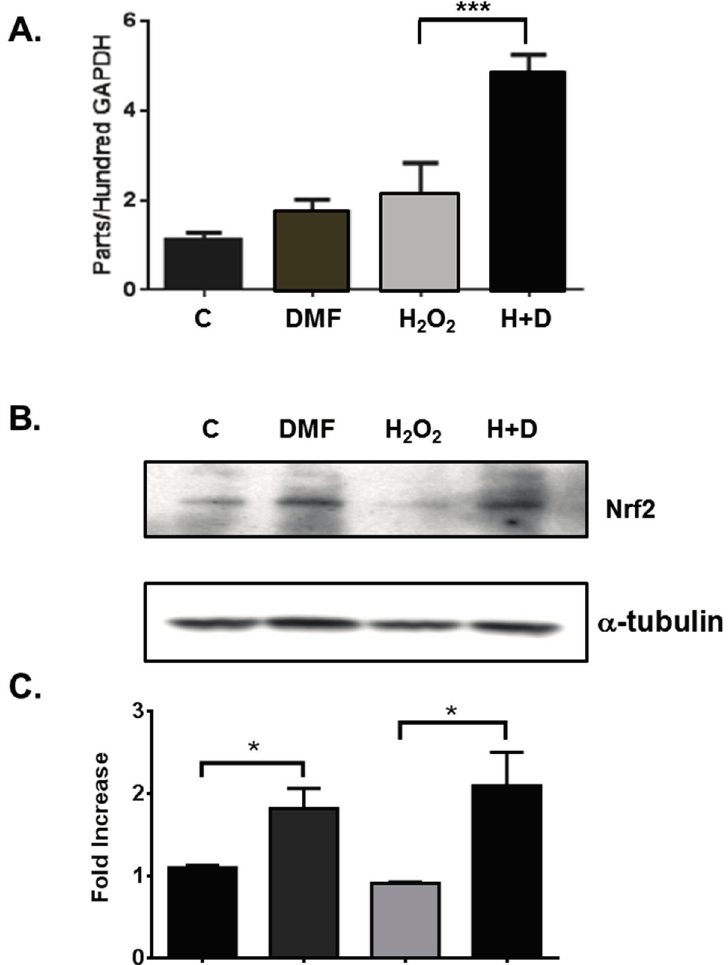
Figure 3. DMF increased Nrf2 RNA and protein expression in rat NPCs in the presence of oxidative stress. After treatment under indicated conditions with DMSO (C), DMF or H 2 O 2 alone, or DMF and H 2 O 2 together, Nrf2 RNA expression was determined using